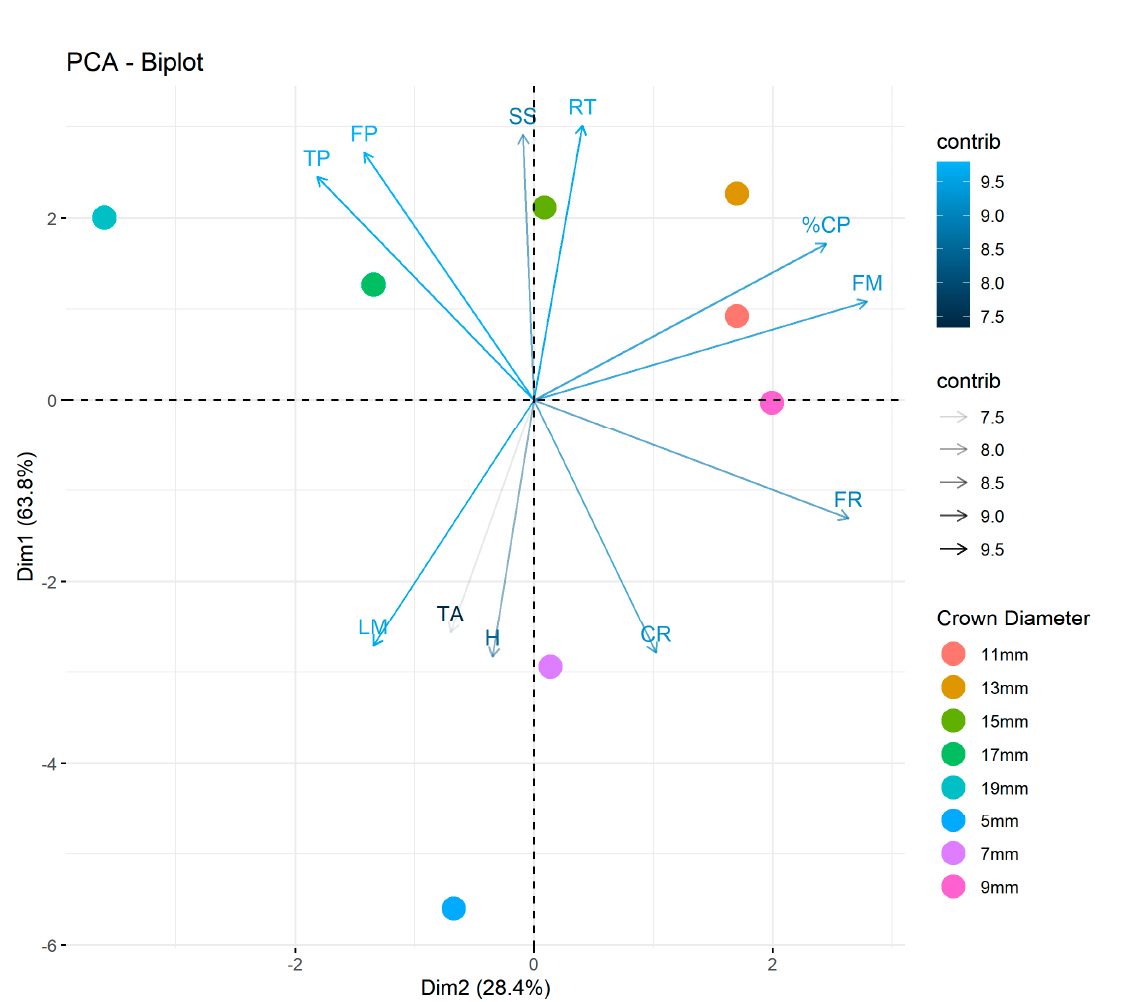
Figure 7. Principal component analysis of the variables in the study concerning the effect of bare-root plants with different crown diameters (5, 7, 9, 11, 13, 15, 17, and 19 mm) on the production and fruit quality parameters of strawberry plants cv. Pircinque. Caption: FP = fruits per plant; TP = total production; FM = fresh mass; % CP = commercial percentage; SS = content of soluble solids; FR = firmness; TA = titratable acidity; RT = soluble solids/titratable acidity ratio; LM = epidermis luminosity; CR = epidermis chroma; and H = epidermis hue angle.